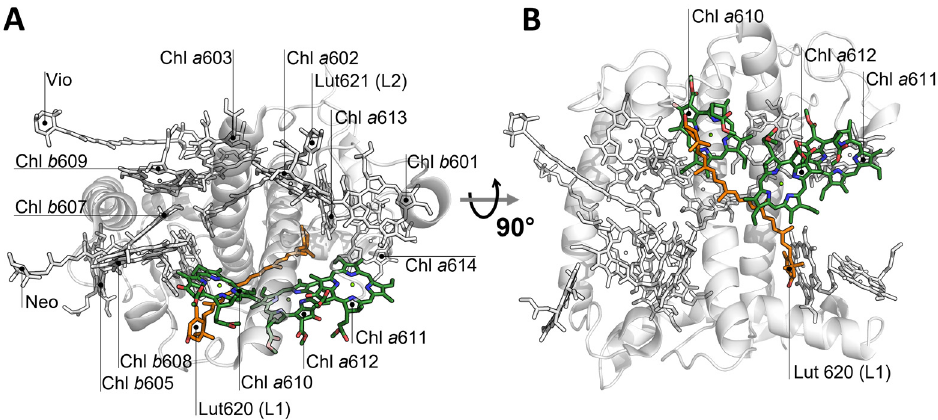
Figure 1. ( A ) Stromal view of LHCII (PDB ID: 1RWT, [2]), where the L1 site is highlighted. Green sticks: Chls a 610, a 611, a 612; orange sticks: lutein at site L1 (Lut620); white sticks: other pigments; white cartoons: polypeptide chains; ( B ) 90° rotation perspective (membrane view).